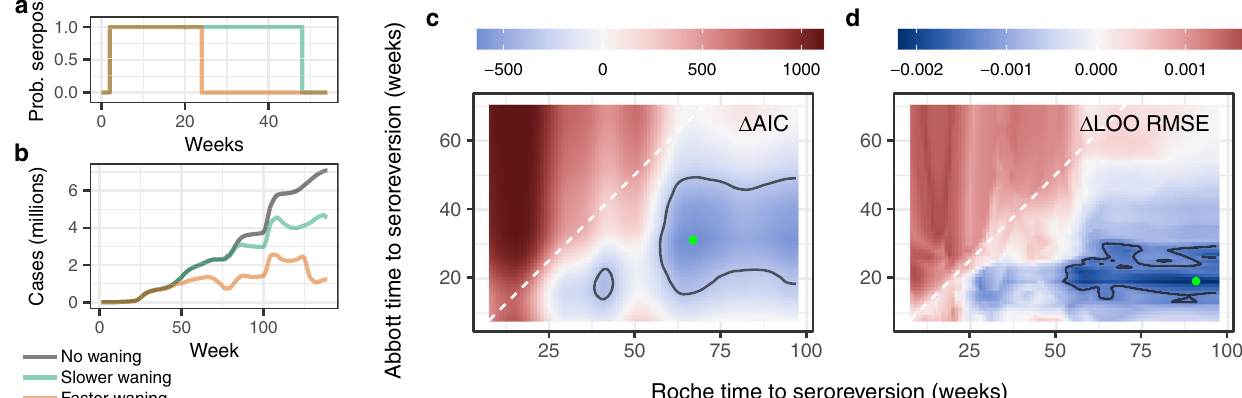
Fig. 2 | Rationale behind the models, and comparison of waning models with the reference model across two metrics. Inclusion of waning helps explain pat- terns in seroprevalence better. Left panels ( a , b ) explain how we mechanistically incorporate waning into the models. In ( a ), a case is expected to test positive in a survey for a limited amount of time before seroreverting, leading to ( b ) different waning patterns that depend on the time to seroreversion (see Supplementary Fig. 15). In our models we use three different times to seroreversion, one for each assay.Withineachtilepanel( c , d ),eachpixelcorrespondstoasinglemodel,where cases have been adjusted assuming three different times to seroreversion, one for each assay. The best models had a case seroconvert 1 week before being reported (Table 1). Tile plots assume the best model ’ s time to seroreversion for the Ortho